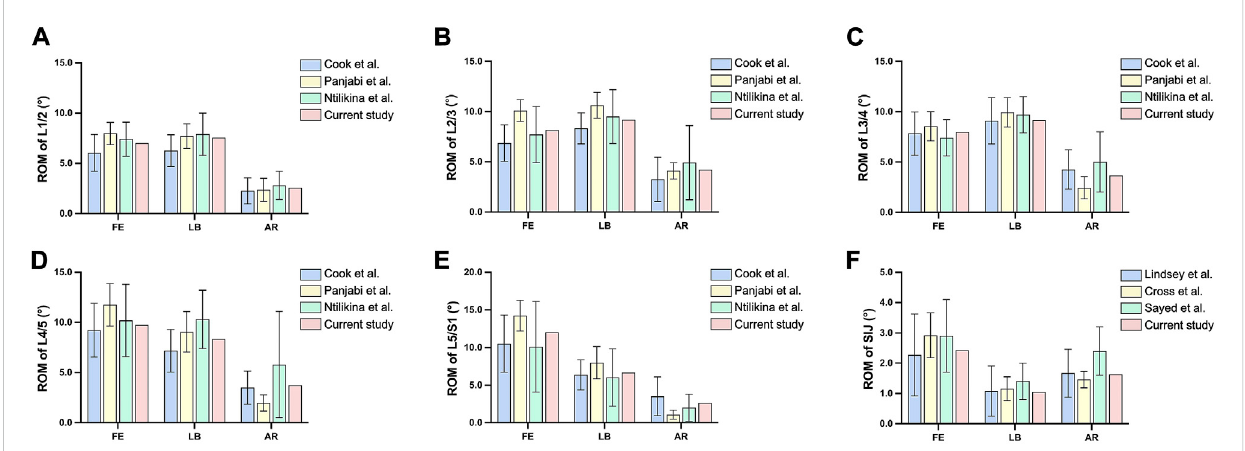
FIGURE 3 Comparison oftherange ofmotionbetween theintactmodeland invitro studies. (A) rangeofmotionofL1/2; (B) rangeofmotionofL2/3; (C) range of motion of L3/4; (D) range of motion of L4/5; (E) range of motion of L5/S1; (F) range of motion of sacroiliac joint.